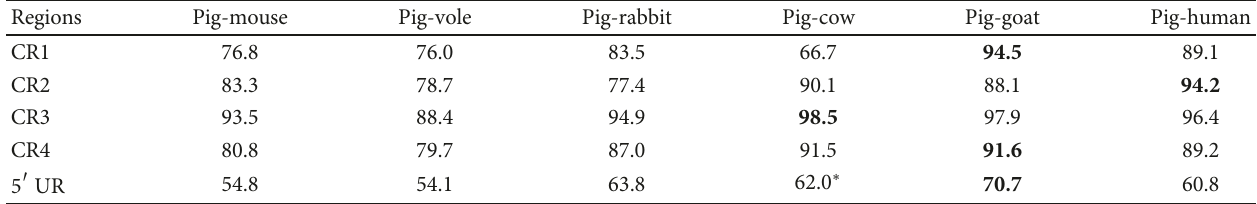
Table 1: Alignment of the nucleotide sequences from porcine OCT4 promoter regions with those of six mammalian species (%). Regions